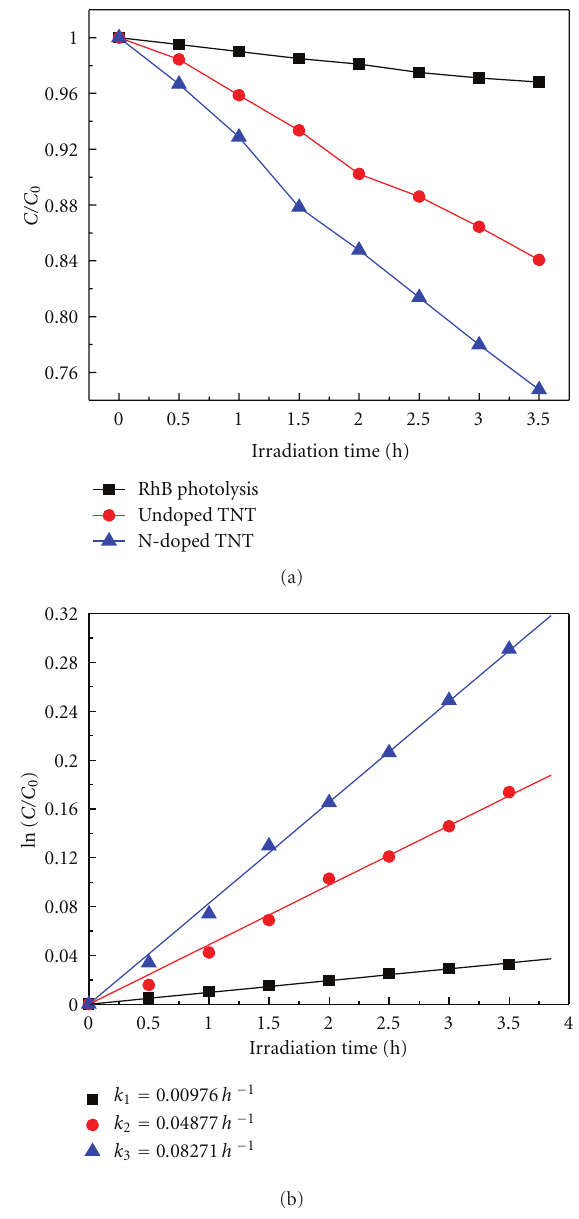
Figure 5: Comparison of (a) degradation rates and (b) kinetic curves by the Rh B degradation using the undoped TNT and N- doped TNT arrays samples. The doping conditions are that reaction voltage is 3 V, reaction time 3h and electrolyte concentration 0.5